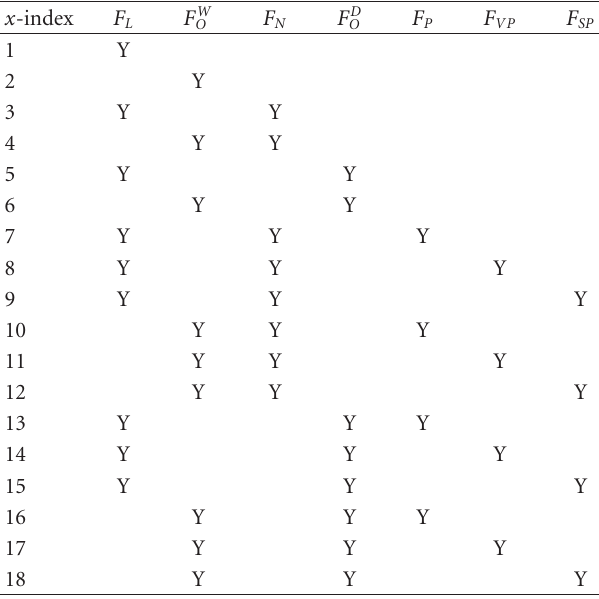
Table 3: Di ff erent combinations of NOSPDM x . Y represents the corresponding model applied in the ( x )th combination.